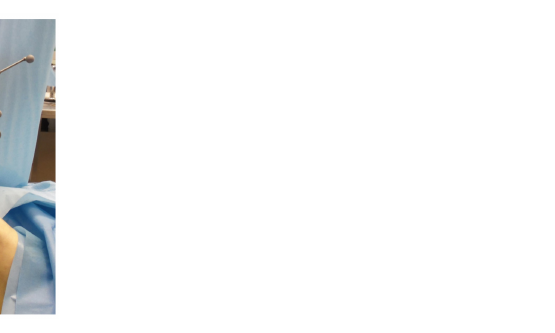
Figure 2. Setting of a cadaveric investigation of knee kinematics using a surgical navigation system.